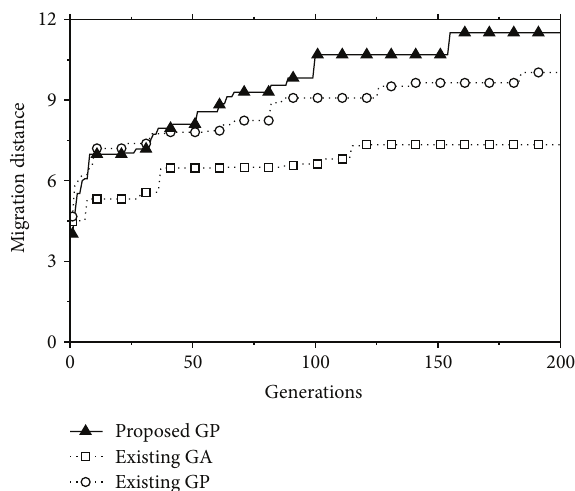
Figure 12: The migration distance achieved by the best individual for 200 seconds as generation